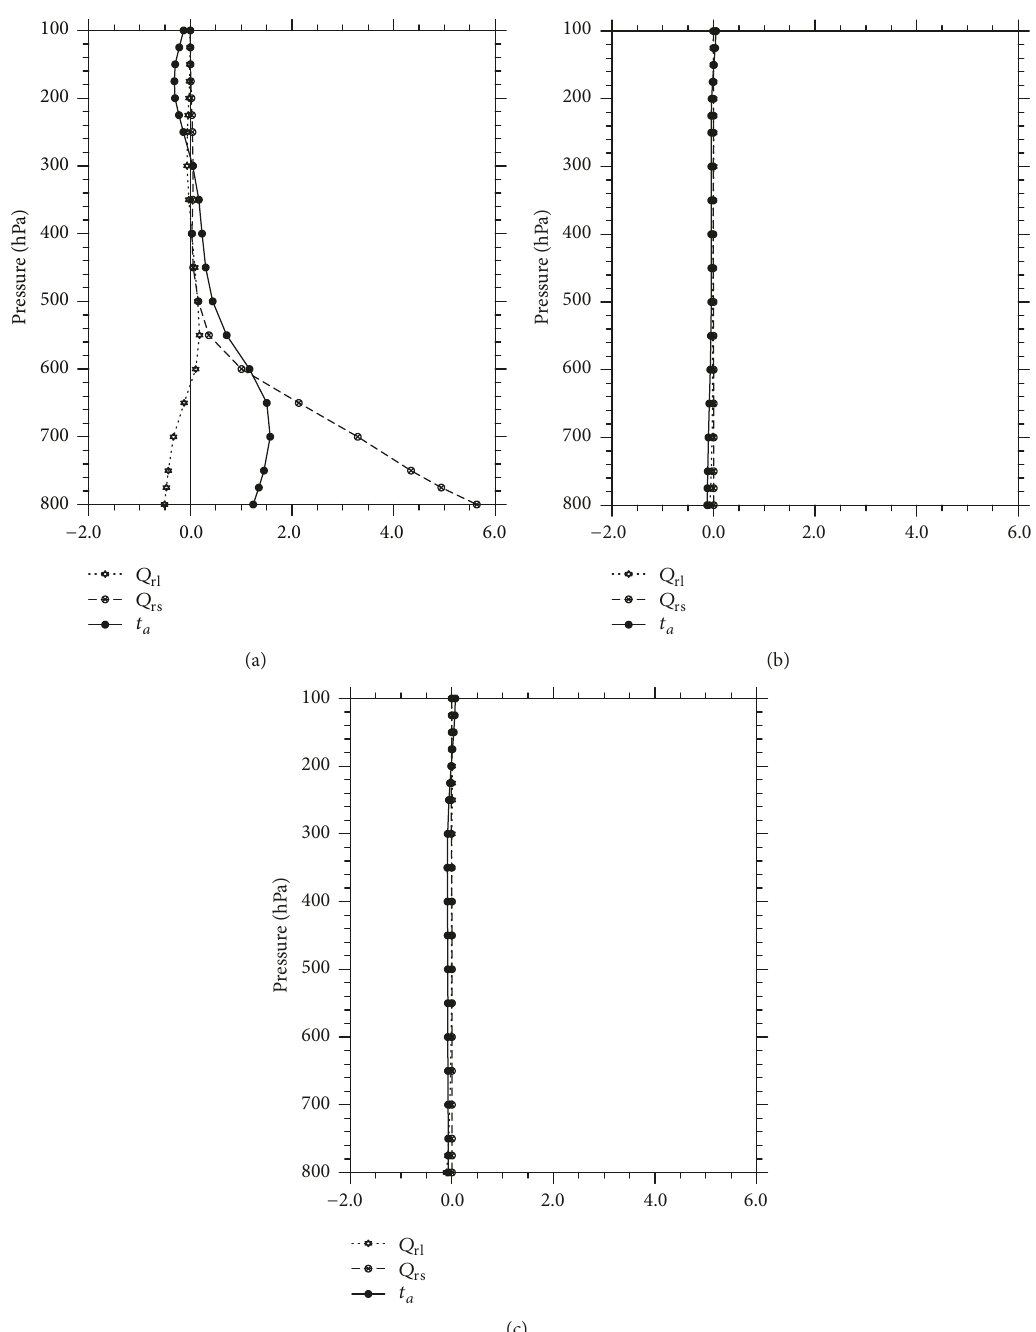
Figure 8: The vertical profile of DIF (SE − CE) for regional averaged air temperature (K), shortwave heating rate ( 𝑄 rs ) ( ∘ Cd −1 ), and longwave heating rate ( 𝑄 rl ) ( ∘ Cd −1 ) in (a) April, (b) May, and (c) June, respectively, in NWC (37.5 ∘ N–47.5 ∘ N, 70 ∘ E–105 ∘ E) averaged from 2001 to